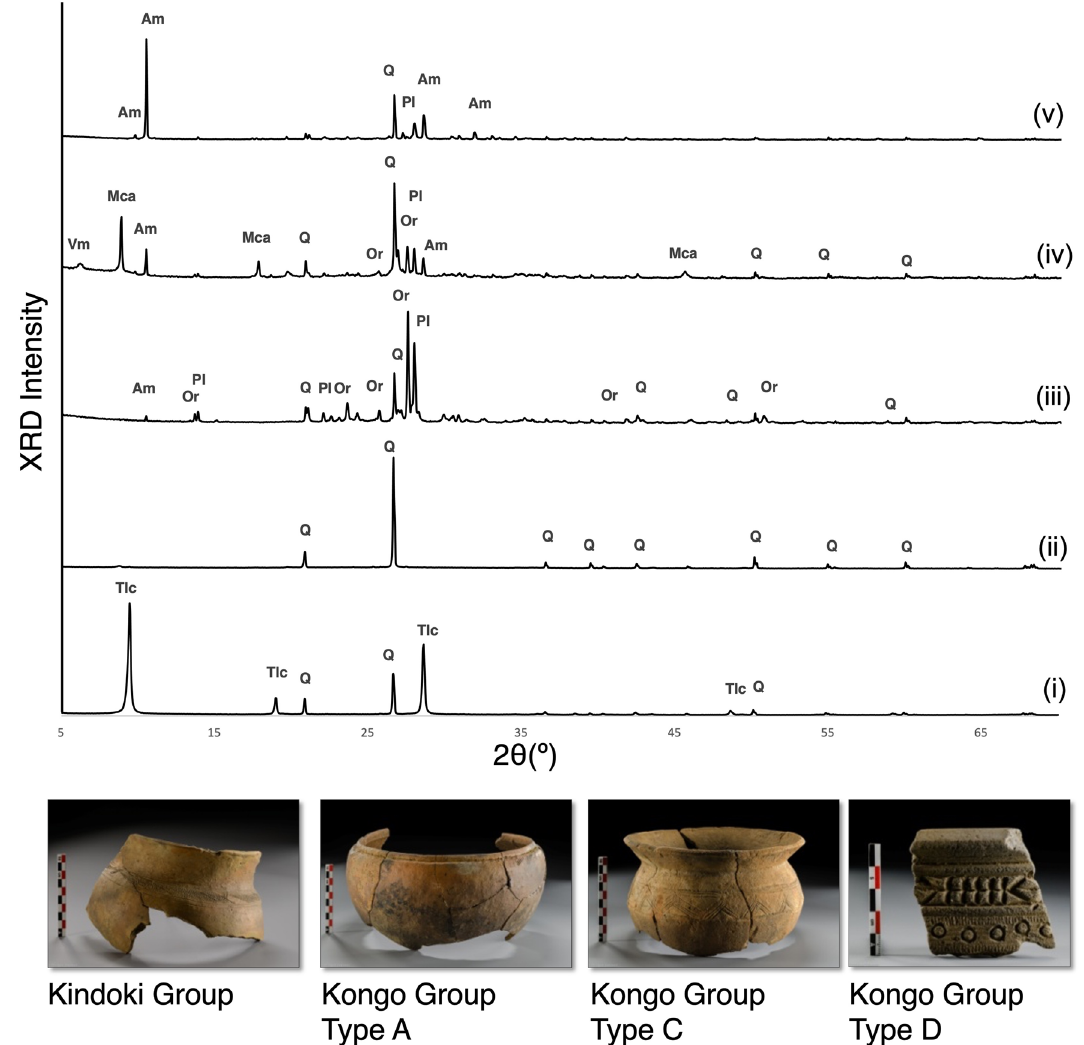
Figure 4. Representative XRD patterns from Kongo kingdom pottery, on the basis of the main crystalline phase, corresponding with the typological groups: (i) talc-rich composition encountered in samples from Kindoki Group and Kongo Type C, (ii) quartz-rich composition encountered in samples from Kindoki Group and Kongo Type C, (iii) feldspar-rich composition encountered in samples from Kongo Type A and Kongo Type D, (iv) mica-rich composition encountered in samples from Kongo Type A and Kongo Type D, (v) amphibole- rich composition encountered in samples from Kongo Type A and Kongo Type D. Q quartz, Pl plagioclase,